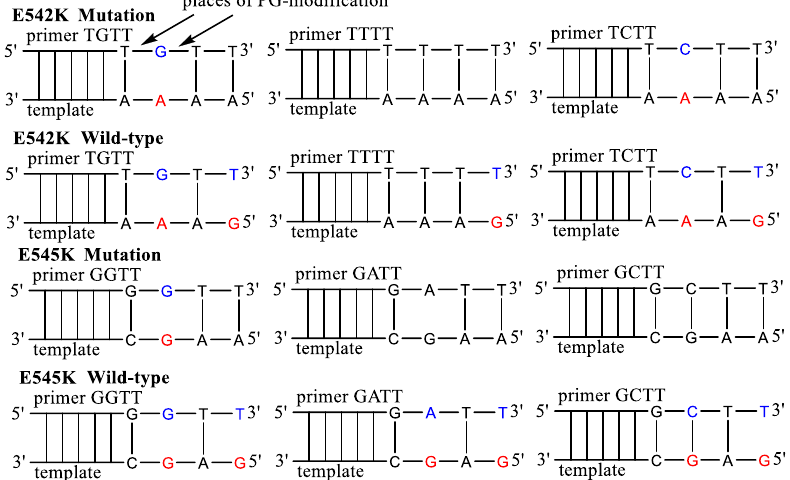
Figure 3. The sequence of PG-modified primers for E542K and E545K mutations detection. The mismatched nucleotides in the template are marked by red, in the primers by blue. The primers harbor additional mismatched nucleotides. Table 2. AS primers for the E542K and E545K mutation detection.